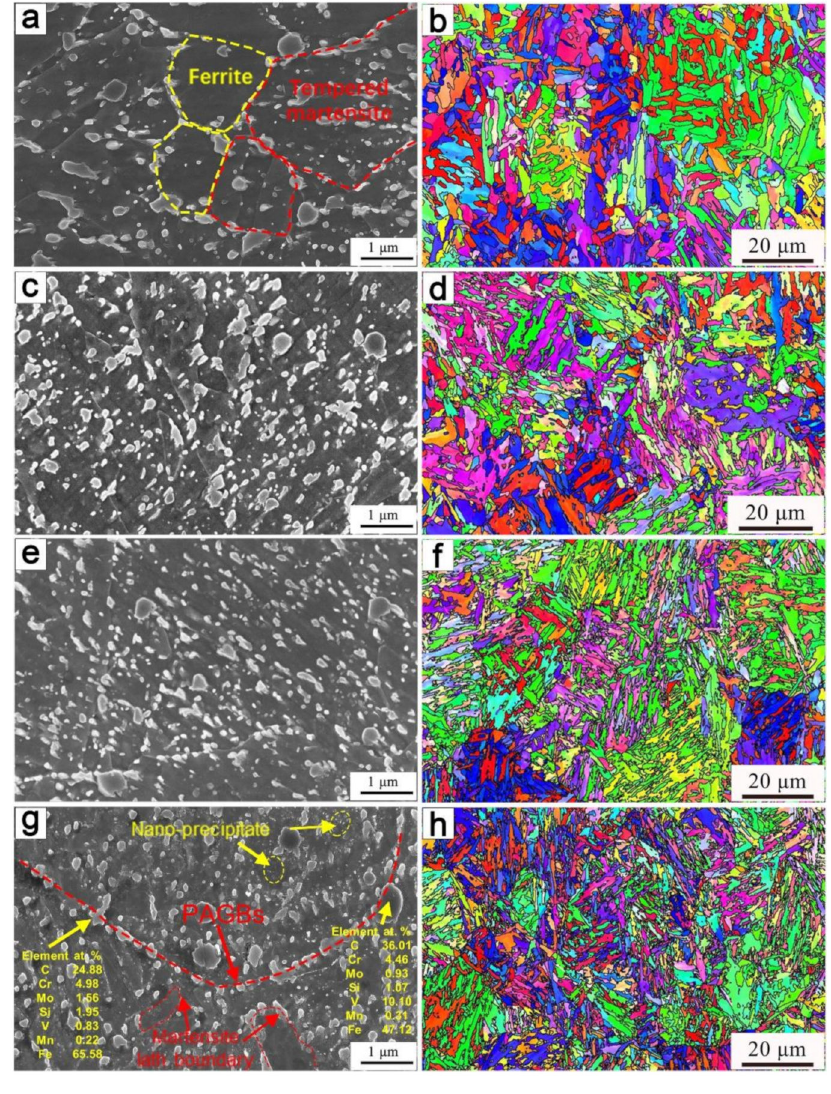
Figure 5. SEM and EBSD images of stage II: ( a , b ) 850-II; ( c , d ) 900-II; ( e , f ) 950-II; ( g , h ) 0-II. Table 2. Precipitate size, volume fraction, density, lath size, and ρ GND of stage